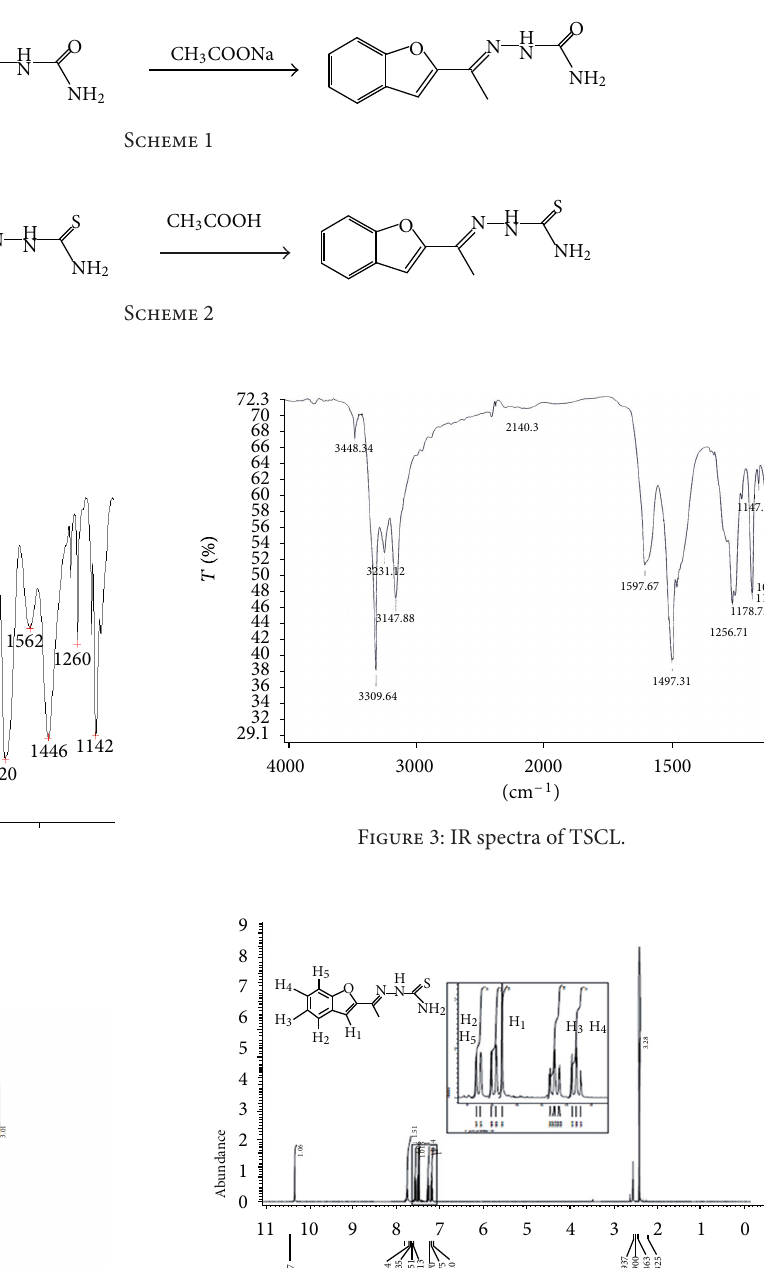
F 4: NMR spectra of